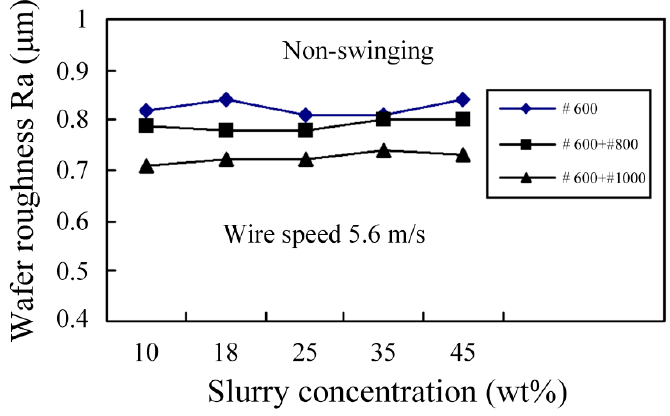
ff ect of slurry concentration on machined SR for Al Figure 8. Effect of slurry concentration on machined SR for Al 2 O 3. Figure 8. Effect of slurry concentration on machined SR for Al 2 O 3. Figure 8. E